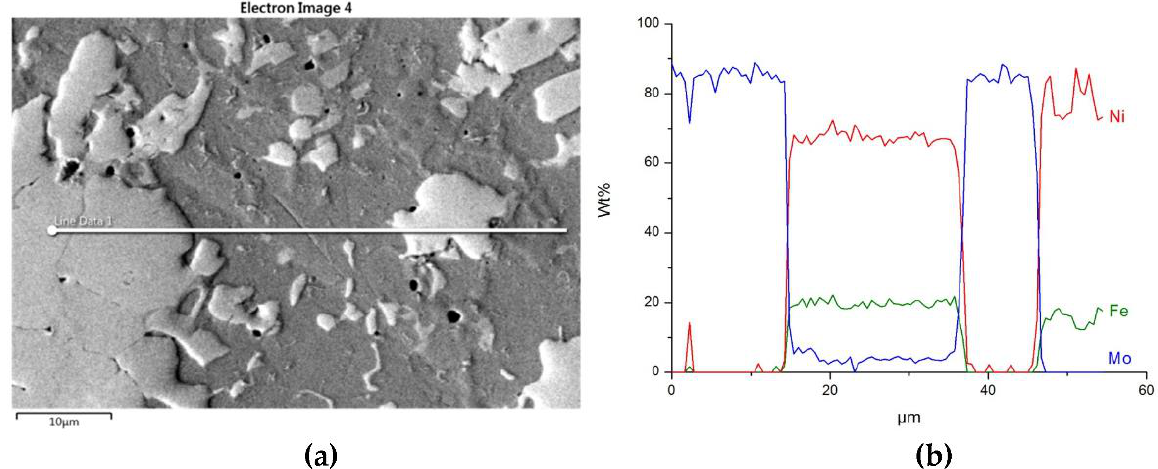
Figure 15. The structure close to the Ni alloy–Mo 2 C interfacial boundary ( a ) and concentrations of elements along the marked line ( b ).